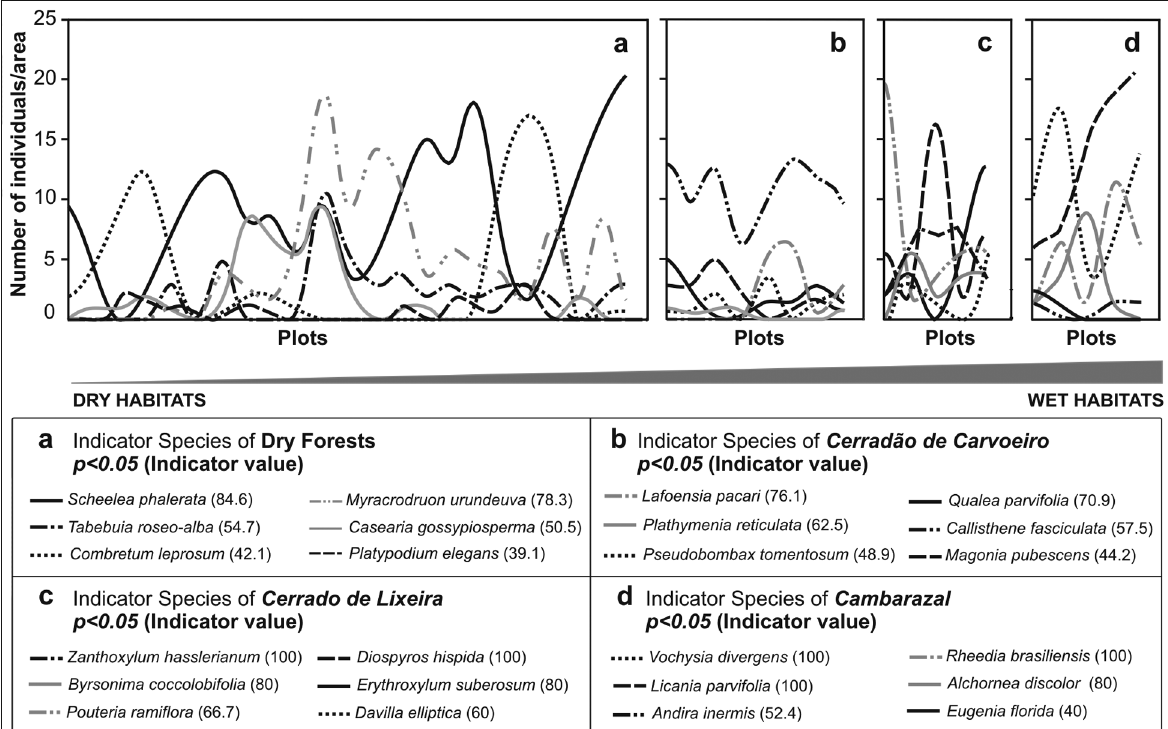
Figure 5 - Gradient direct analysis with distribution of the species identi fi ed as signi fi cant indicators based on Indicator Species Analysis (ISA) in each phytophysiognomy of Brazilian